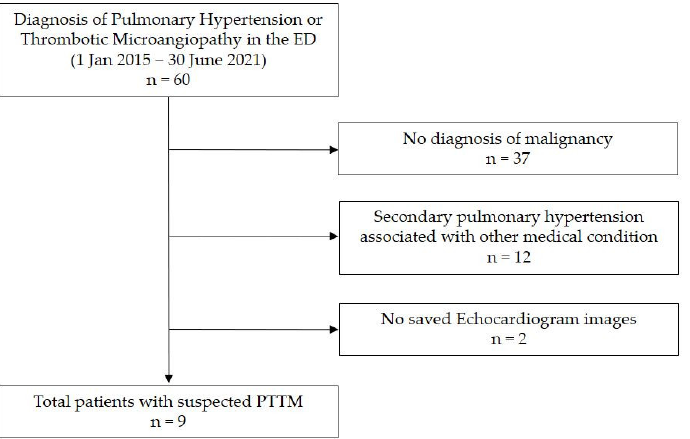
Figure 1. Study patients. Abbreviations: ED, emergency department; PTTM, pulmonary tumor thrombotic microangiopathy.